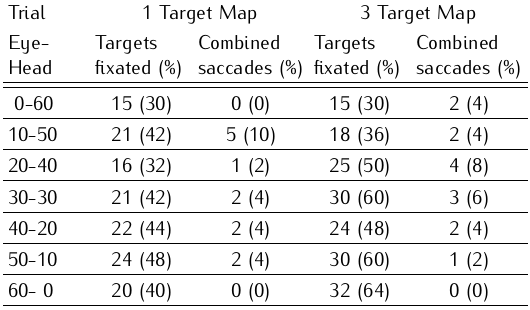
Table 2. Numberoftargetsfixatedbasedonmappingslearntwithoneandthree targets using the eyes and the